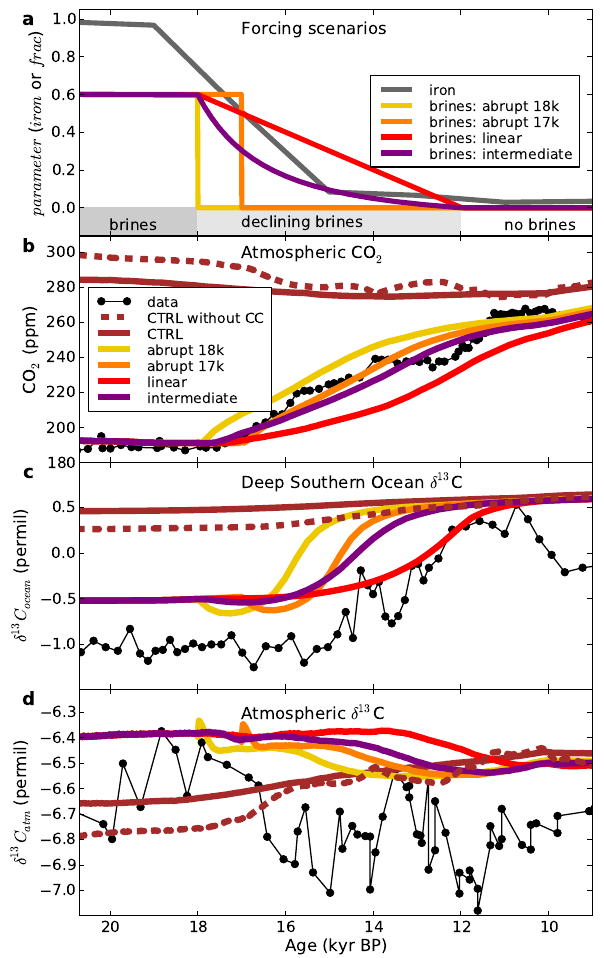
Fig. 14. Forcing scenarios and simulated evolution of atmospheric CO 2 , deep Southern Ocean δ 13 C and atmospheric δ 13 C during the deglaciation. (a) Evolution scenarios for the iron fertilization ( iron parameter, grey) based on the dust transport as recorded in ice cores (Wolff et al., 2006) on the EDC3 age model (Parrenin et al., 2007), and sinking of brines (frac parameter, colors), (b) simulated evo- lution of atmospheric CO 2 (ppm) for the control run (“CTRL” in brown, without carbonate compensation: dotted line and with car- bonate compensation: solid line) and with three additional mech- anisms: interactive diffusion, iron fertilization and different brine scenarios as described in (a) compared to data (black), (c) evolution of deep Southern Ocean δ 13 C (‰) for the same simulations and (d) of atmospheric δ 13 C